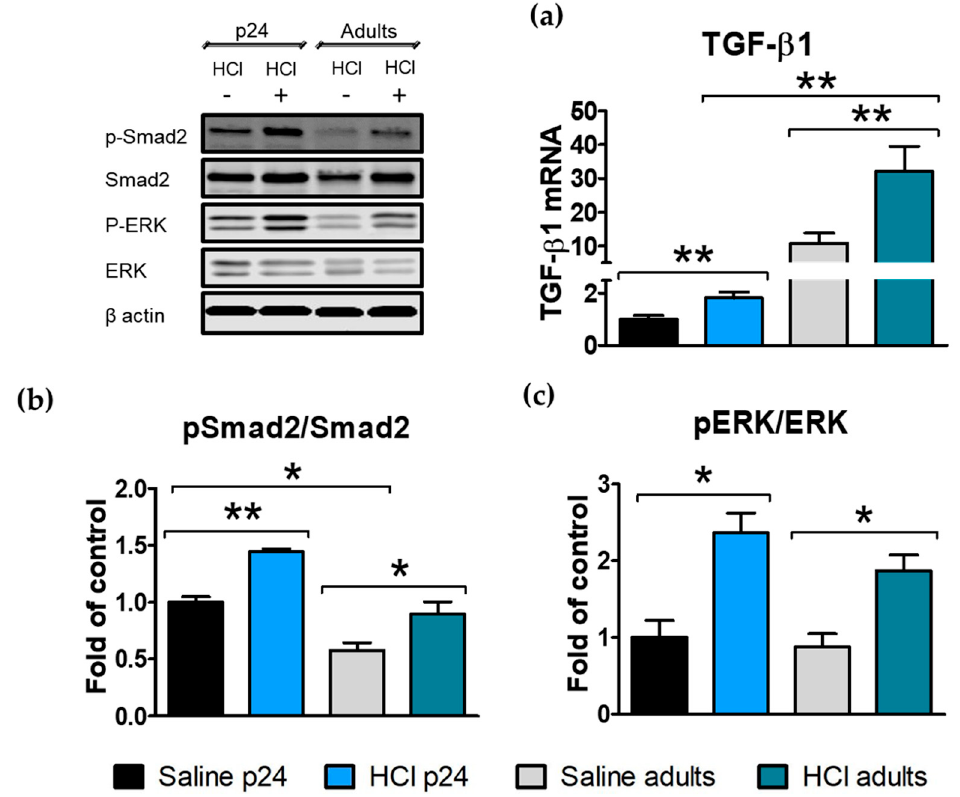
Figure 3. HCl induces age-dependent increases in TGF- β and its intracellular signaling 30 days after HCl-instillation. ( a ) Young and adult mice treated with HCl showed increased expression levels of TGF- β 1 mRNA compared with their corresponding saline controls. ( b ) The phosphoryla- tion of Smad2 was significantly increased in both adult and young HCl-treated mice. ( c ) The acti- vation of ERK increased in both young p24 and adult mice instilled with HCl. Histograms repre- sent the quantification of the blots. Means ± SEM, n = 3–4, * p < 0.05; ** p < 0.01 with one-way ANOVA and Tukey’s